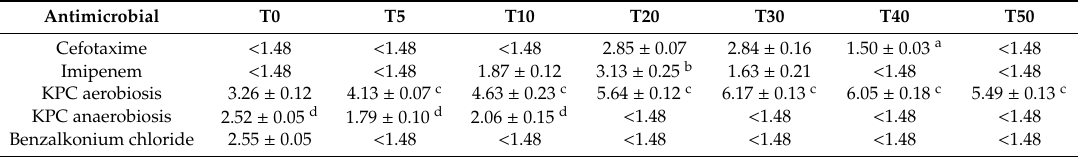
Table 2. Viable cell counts of untreated guacamole samples on media containing antimicrobials.